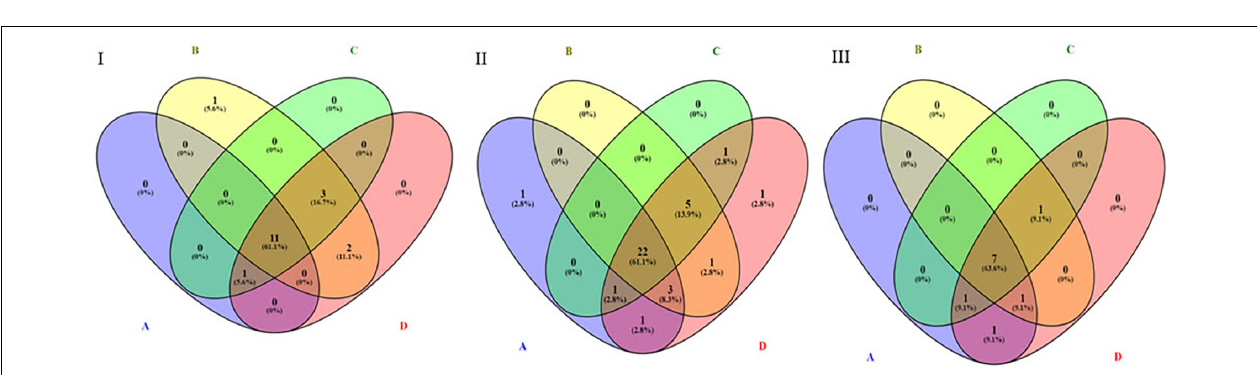
FIGURE 4 | Venn diagram representing the distribution of upregulated miRNAs in various pharmacogenomic pathways. A – ABC transporters, B – drug metabolism cytochrome P450, C – drug metabolism other enzymes, D – metabolic pathways. (I) Upregulated in 25 µ M HLP vs. control, (II) Upregulated in 25 µ M CLZ vs. control, (III) Upregulated in 25 µ M HLP + 25 µ M CLZ vs. control.